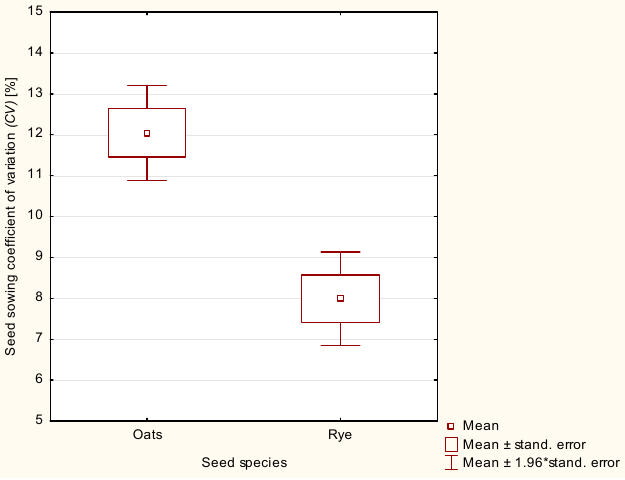
Figure 12. The values of the coefficient of variation (CV) for sowing evenness depending on the seed species.